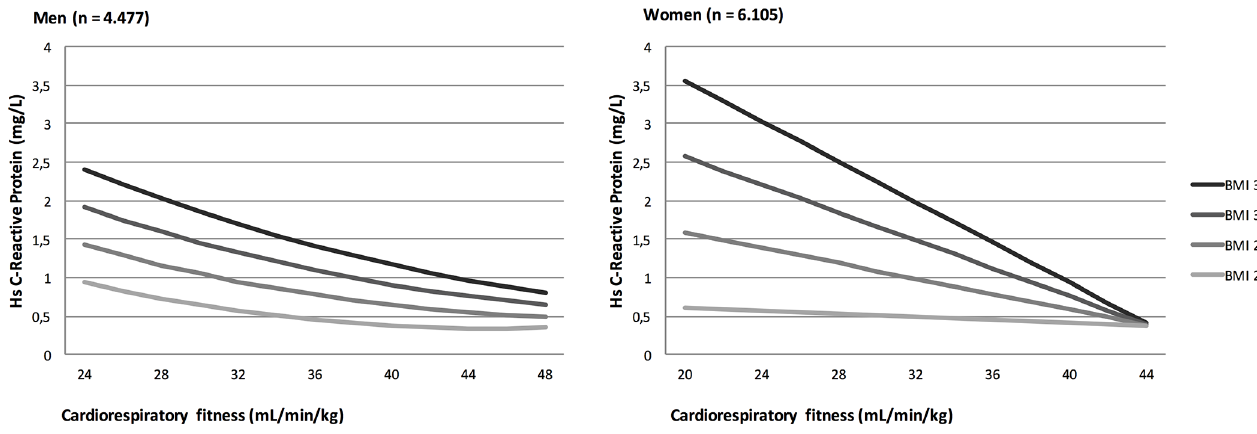
Fig 4. High sensitivity C-reactiveprotein by cardiorespiratory fitness and BMI in men and women. Valuesare estimated, from the regressionmodel, for a 40 year old woman or man with a BMI (kg/m 2 ) of respectively20, 25, 30 or 35.